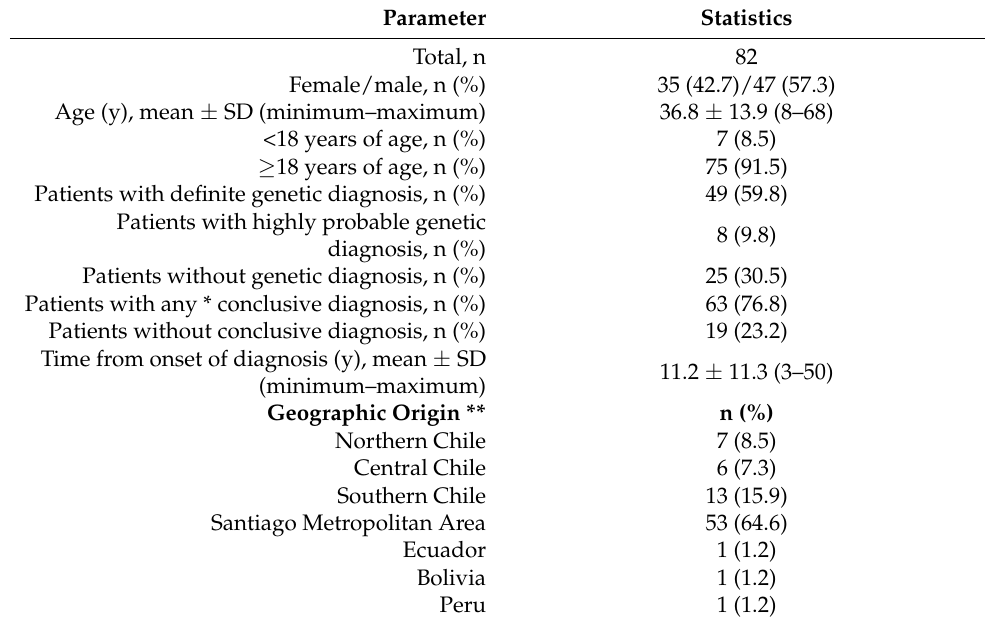
Table 1. Demographic data of the series.